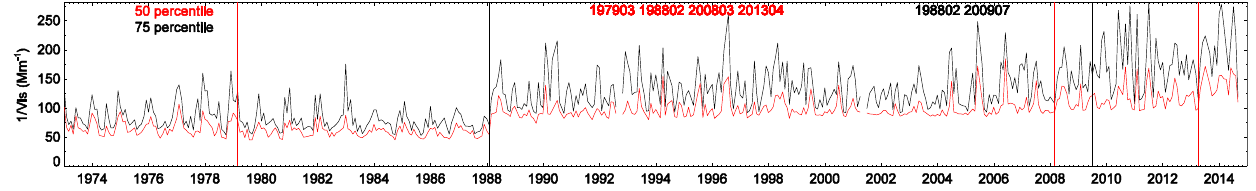
Figure 1. An example of change point detection and determination based on the time series of 50th (red) and 75th (black) percentiles of monthly 1/Vis. Automatically detected change points are represented by vertical lines. Text in the inset lists the dates of automatically detected points. In this example, five significant change points are identified, in which February 1988 is determined as the separation point for further analysis, while other reported breaks are considered to be false